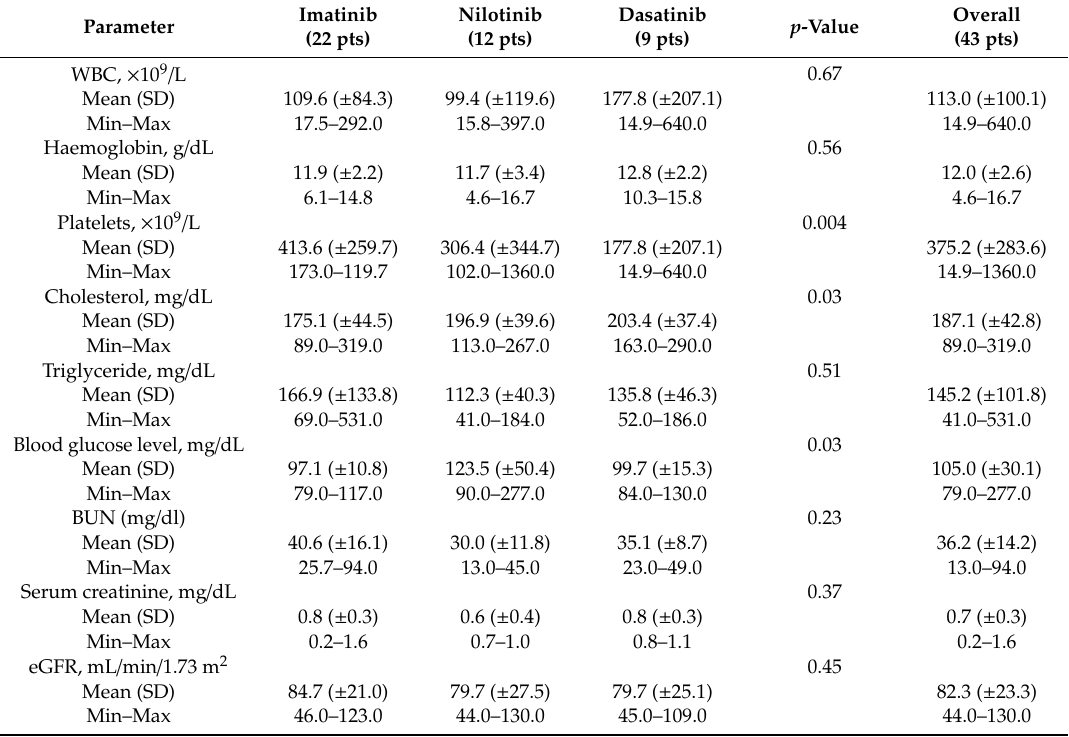
Table 2. Laboratory tests at the time of diagnosis.